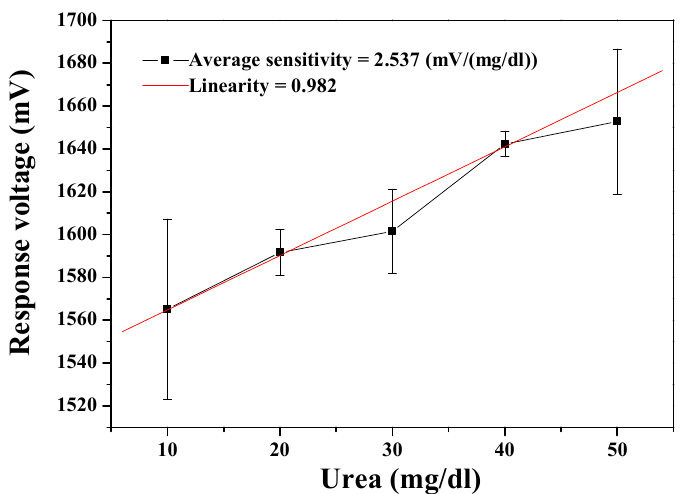
Figure 5. Responses of the urea biosensor based on MBs-urease/GO/TiO 2 by integrating the wireless measurement system.